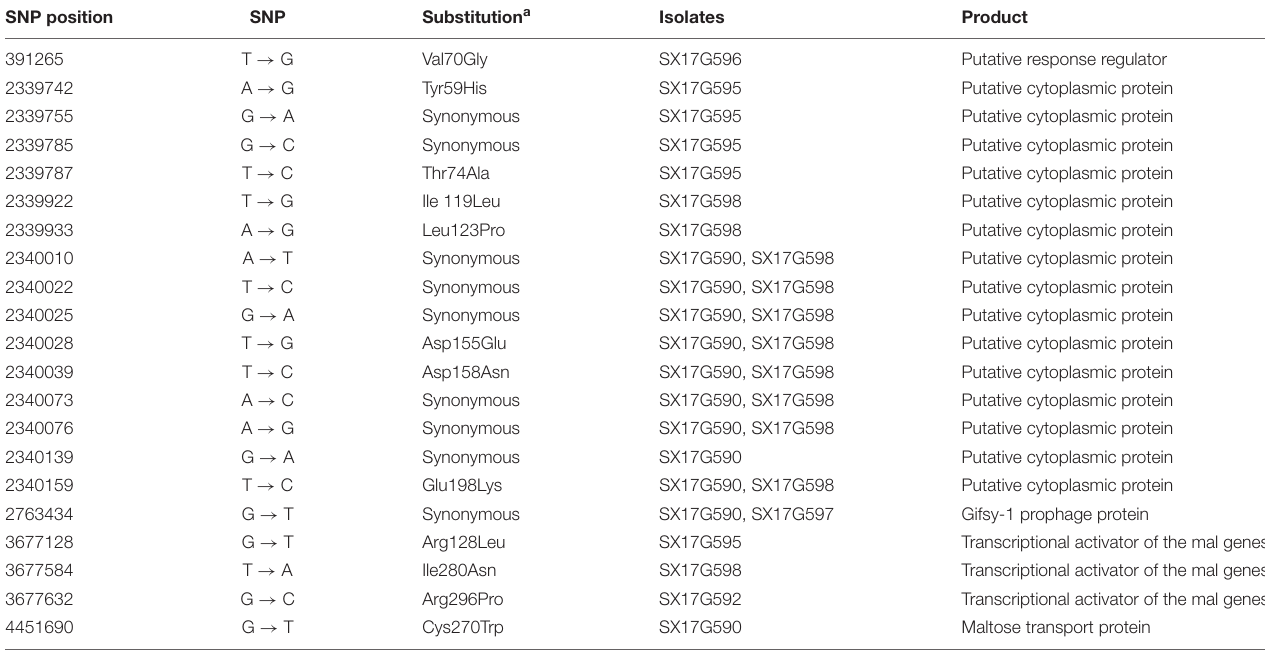
TABLE 2 | The SNP differences detected among the isolates from this